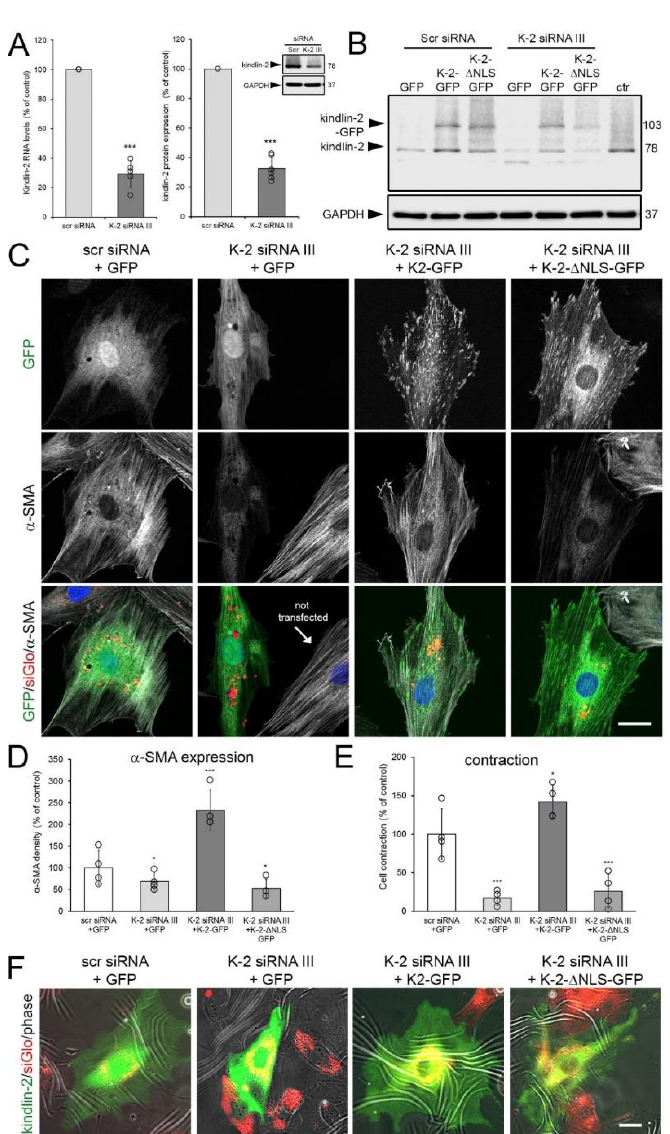
Figure 7. Wild-type but not kindlin-2 missing the putative nuclear localization sequence (NLS) ( ∆ NLS-kindlin-2) rescues myofibroblasts after knockdown of kindlin-2. ( A ) Rat embryonic fibroblasts (REF) were transiently transfected with two 3 (cid:48) -UTR-targeting kindlin2 siRNAs (K-2 siRNA III) and assessed 48 h later using quantitative immunoblotting and qRT-PCR, both normalized to glyceraldehyde 3-phosphate dehydrogenase (GAPDH) loading control. ( B ) Such kindlin knockdown (K-2 siRNA III) or control (scr siRNA) REF were then transfected with plasmid constructs to express GFP, kindlin-2-GFP, and kindlin-2- ∆ NLS-GFP and assessed for kindlin-2 expression by immunoblotting, compared to non-transfected REF (ctr). ( C ) Additional transfection with siGlo at the time of knockdown was used to assess expression of GFP constructs (green) and α -smooth muscle actin ( α -SMA) (greyscale) in transfected REF (red, siGlo) by confocal microscopy. ( D ) Respective low magnification images were used to quantify the percentage of α -SMA-positive cells by manually counting α -SMA stress fiber-positive fibroblasts in the siGlo / GFP double-positive fraction ( ≥ 10 cells / image, ≥ 5 images / experimental condition). ( E , F ) The same approach was used to quantify the percentage of contractile siGlo (red) / GFP (green) double-positive REF grown for 8 h on wrinkling elastomers (wrinkles-white) from epifluorescence images. All graphs show mean values from at least three independent experiments (data points) ± SD (* p < 0.05, *** p < 0.005, using ANOVA followed by a post-hoc Tukey’s multiple comparison test). Scale bars: 25 µ